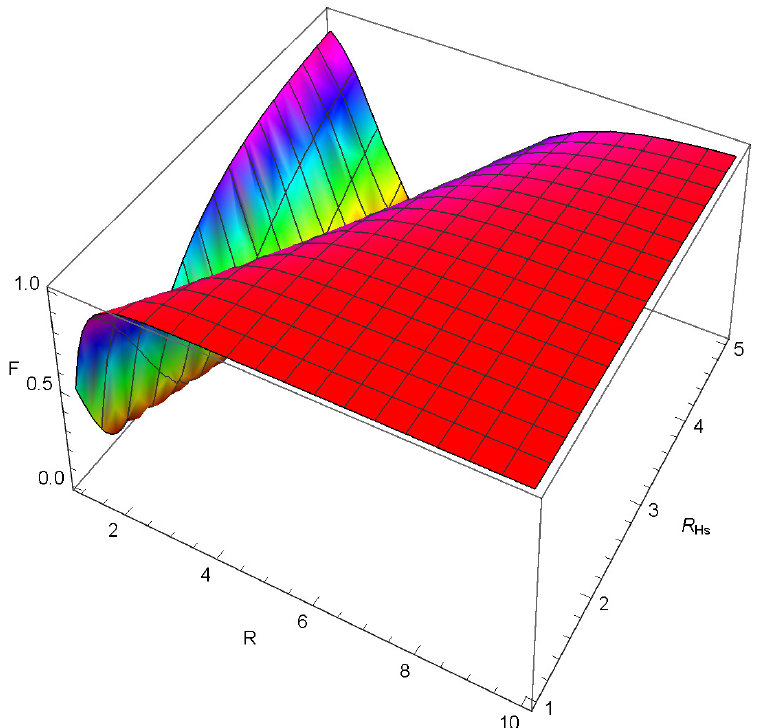
Figure 21. Solution of F ( R ) for p = 4. The evolution of the partial derivative of f ( R ) is obtained using Equations (33) and